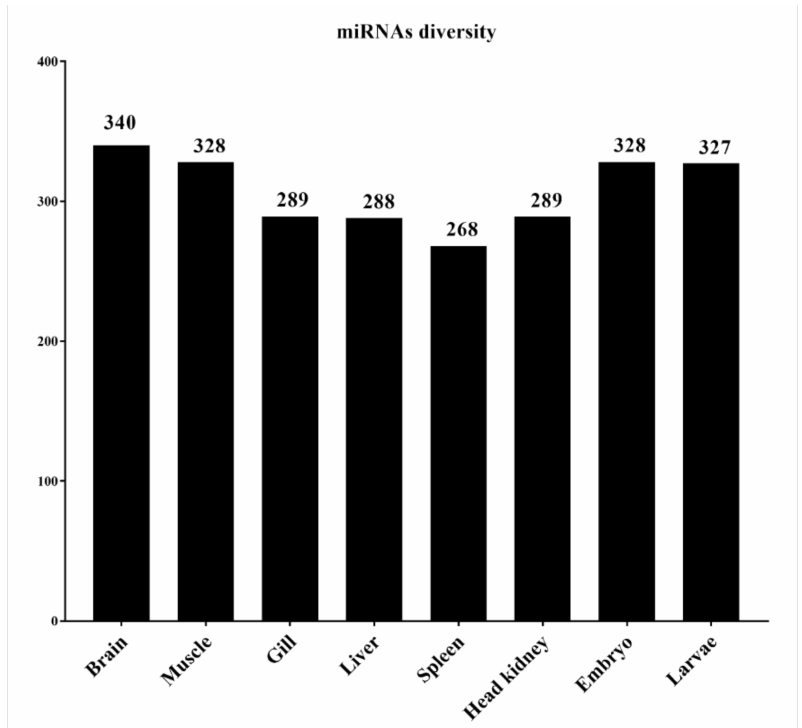
Figure 2. miRNA diversity in lumpfish tissue/organs and early developmental